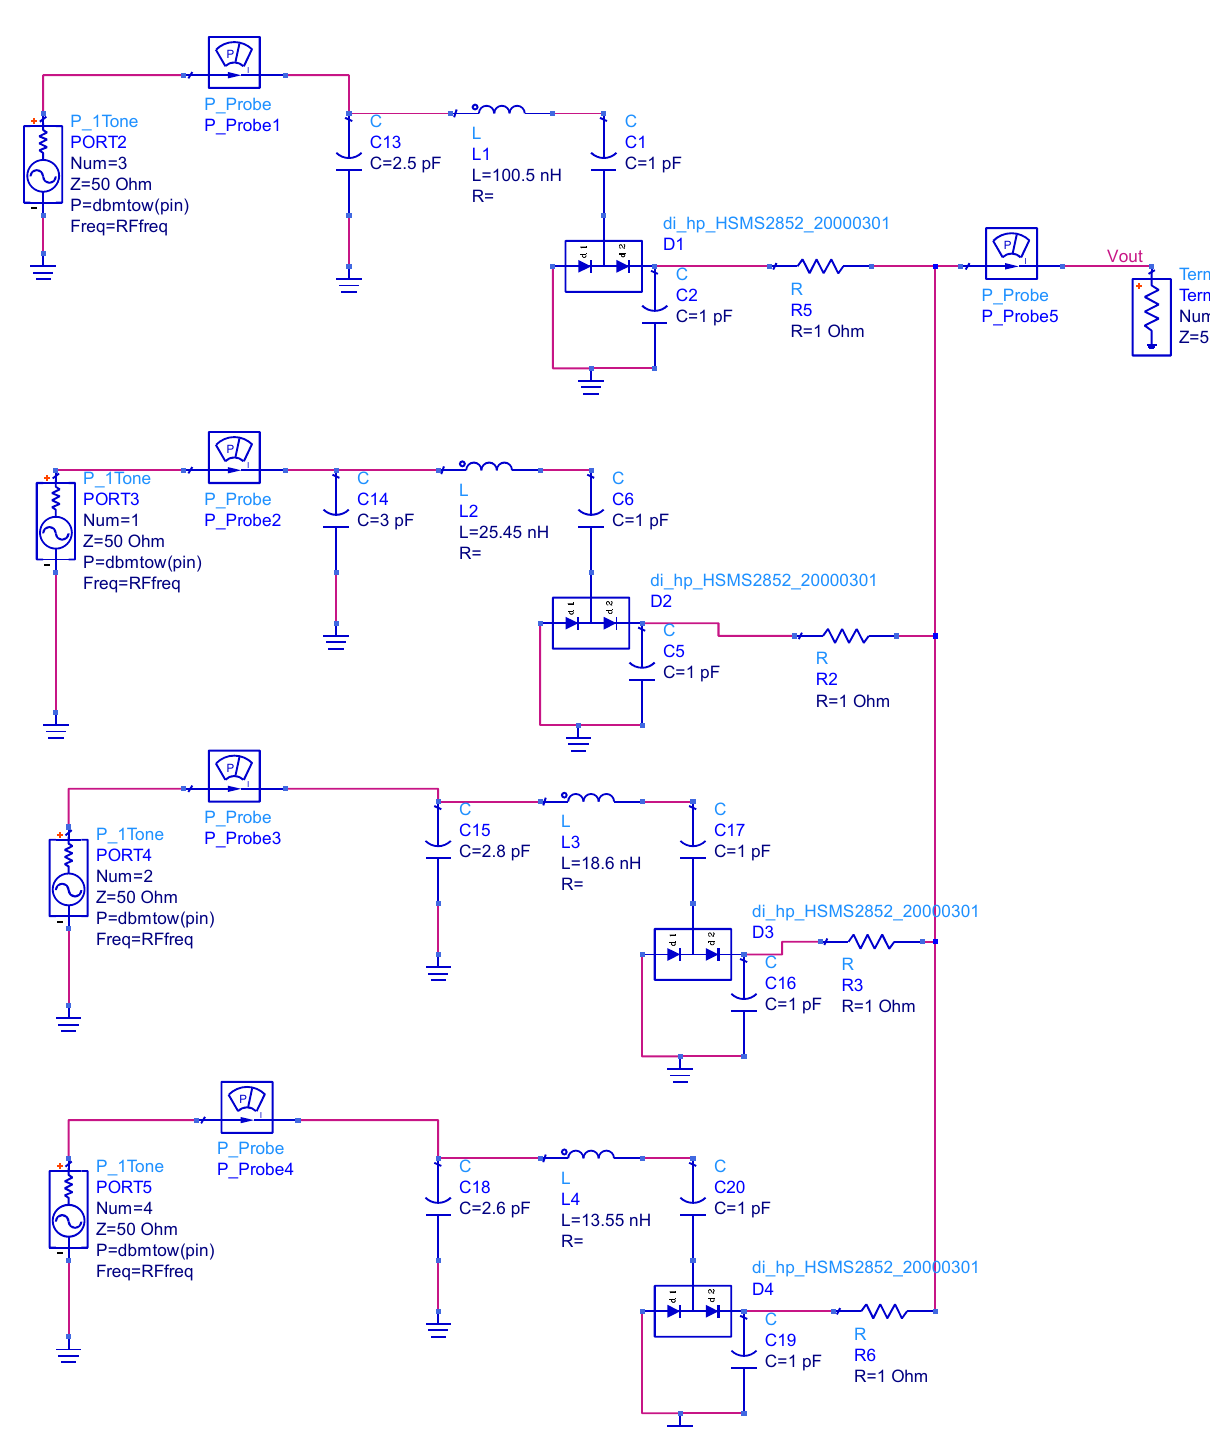
Figure 9. Improved quad-band circuit with the four series